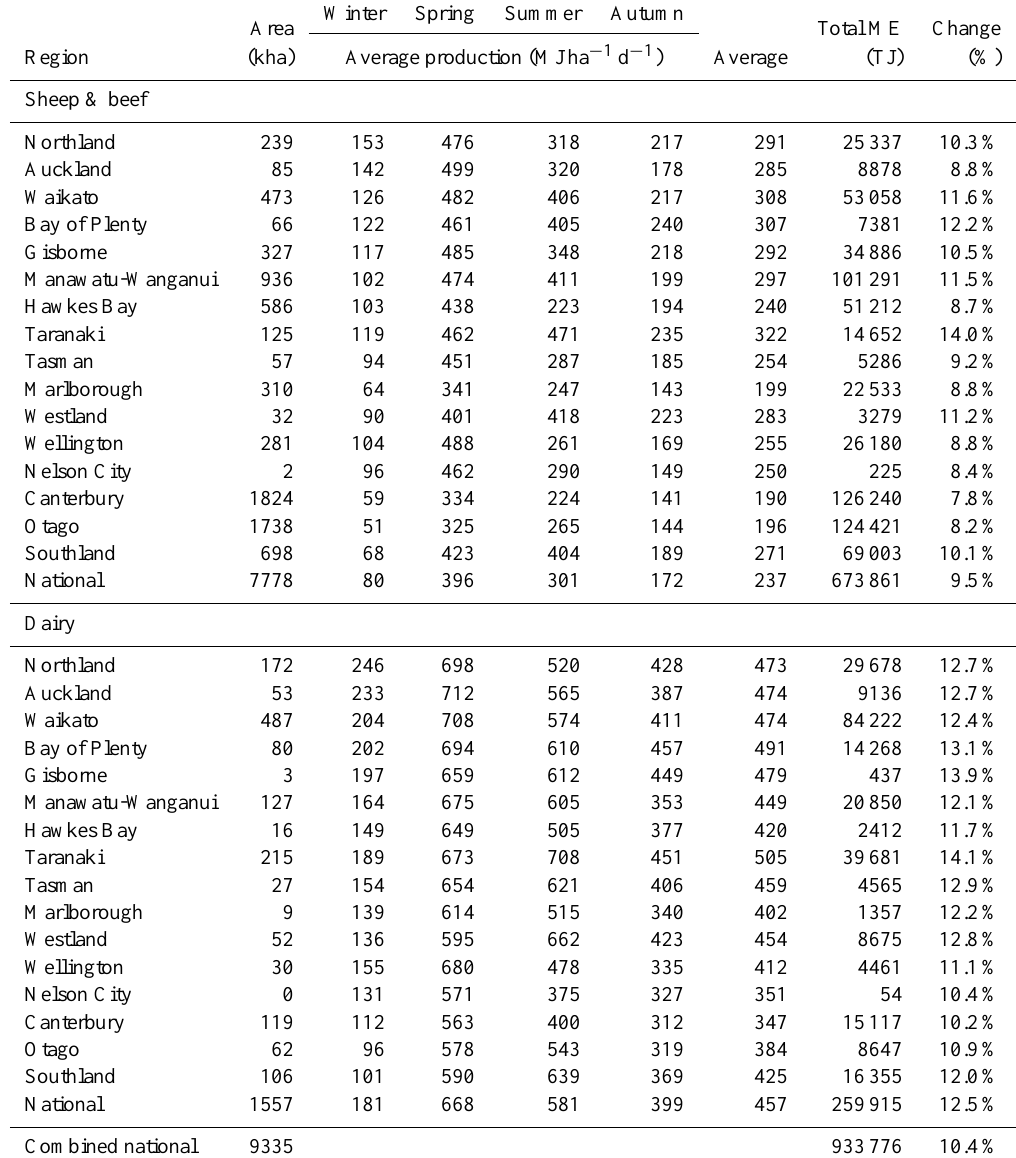
Table B4. Intensification